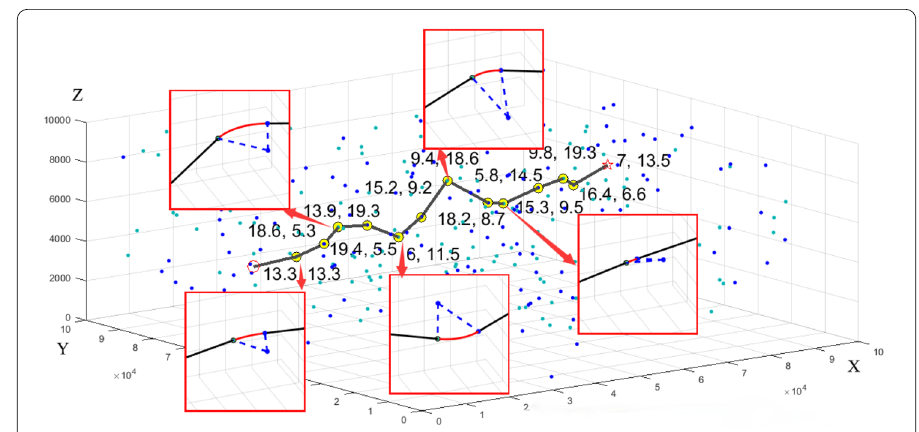
Figure 10 Spatial route planning representation in data set 2